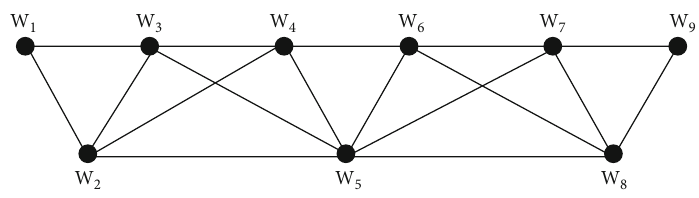
Figure 3: Line graph of triangular ortho chain cactus L ð T